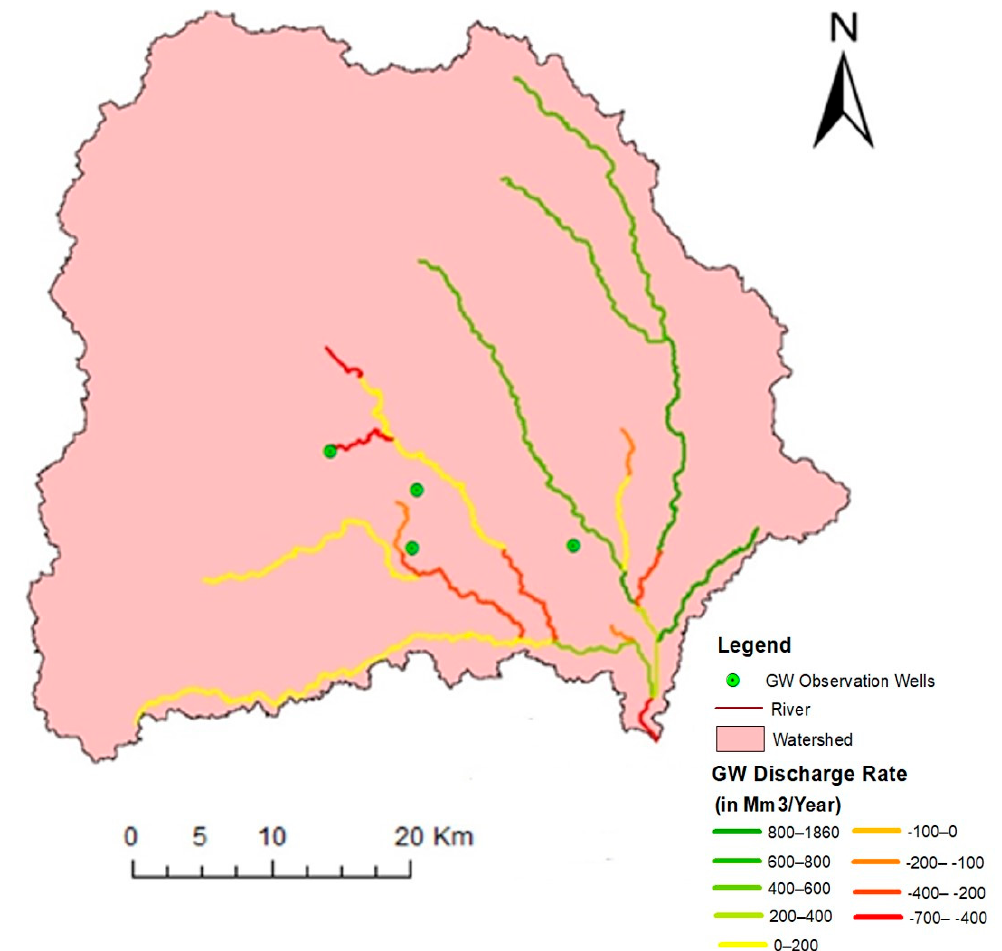
Figure 11. Simulated average annual groundwater discharge (Mm 3 /year) from the aquifer to the stream network for selected study period, (2000–2017). The streams which are highlighted in green indicate GW discharge from the aquifer to the streams and the streams which are highlighted in red indicate the seepage from the stream to the aquifer as shown in Figure 11.